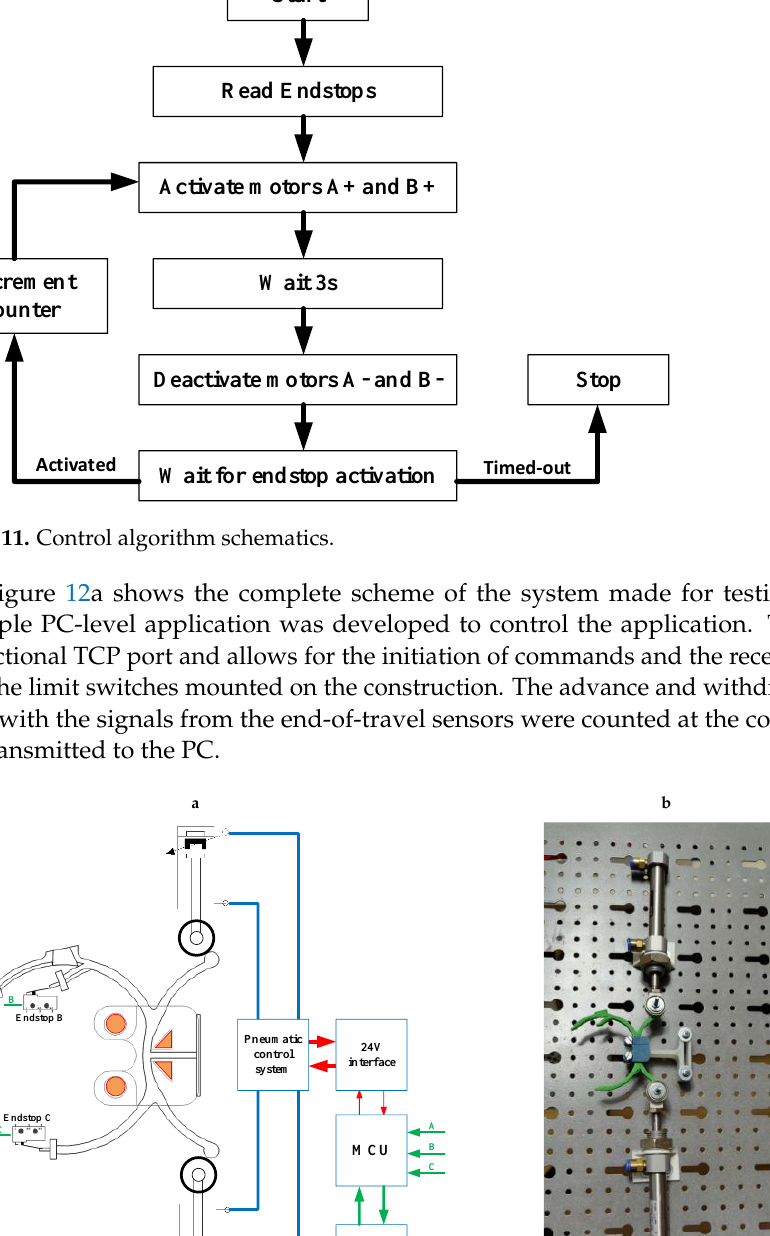
Figure 11. Control algorithm schematics.